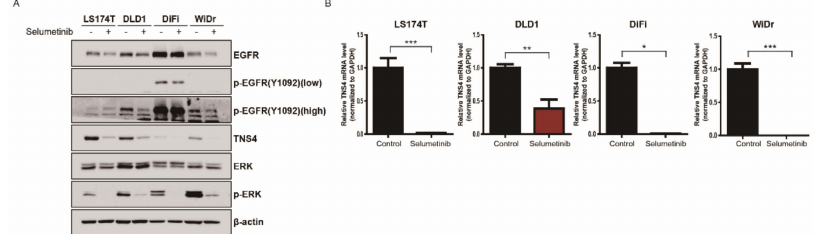
Figure 4. TNS4 expression is regulated by MAP kinase pathways at a transcriptional level. ( A ) LS174T, DLD1, DiFi and WiDr cells were incubated for 24 h with or without 1 µ M selumetinib, and the resulting cell lysates were subjected to immunoblotting with the indicated antibodies. ( B ) The total mRNA isolated from LS174T, DLD1, DiFi, and WiDr cells treated with selumetinib (1 µ M) for 24 h were used for qPCR analysis with primer sets targeting TNS4 . The bar graphs show the relative mRNA levels of TNS4 in selumetinib-treated cells were normalized to that of untreated cells (*, p < 0.5; **, p < 0.01; and ***, p <